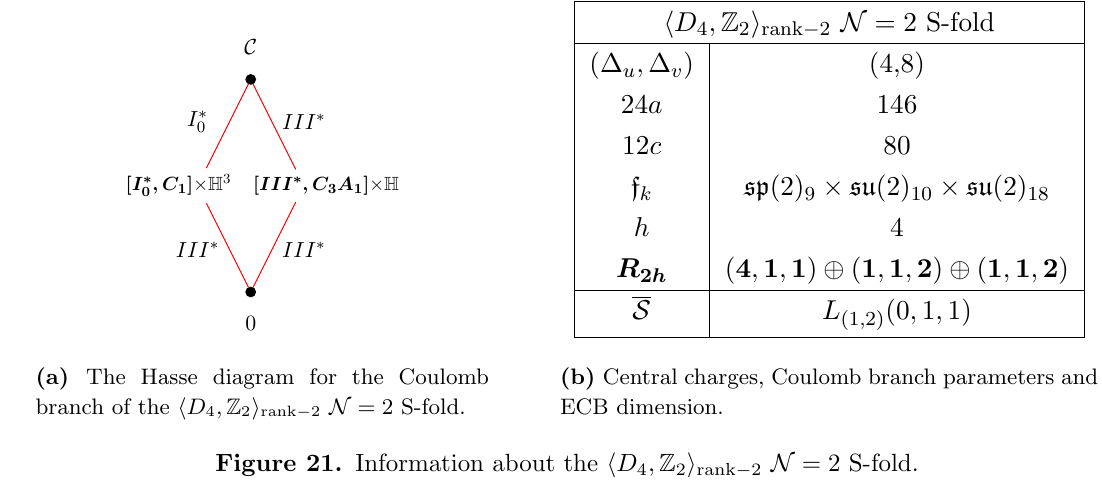
Figure 21. Information about the h D 4 ; Z 2 i rank (cid:0) 2 N = 2